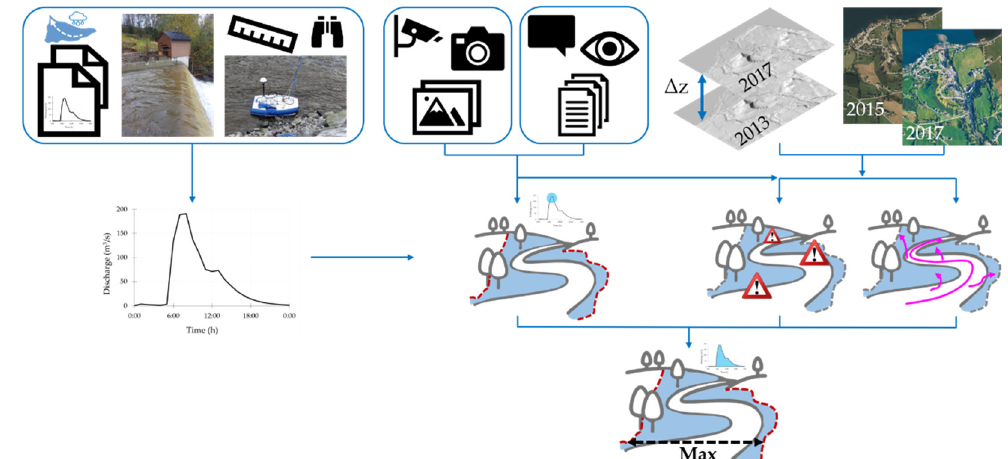
Figure 2. Schematic workflow followed. From left to right and top to bottom: ( left ) hydrologic study [8] provided the hydrograph for the 2017 flash flood, which was used together with visual documentation and testimonies ( center ) to assess the flood area at Q peak ; ( right ) the topographic difference and orthophotos contributed to identifying critical points and preferential flow paths during the flood, which were later refined using the aforementioned flood documentation. The combination of the flood area at Q peak , critical points and preferential flow paths resulted in the estimated maximum flooded area during the whole event ( bottom ).